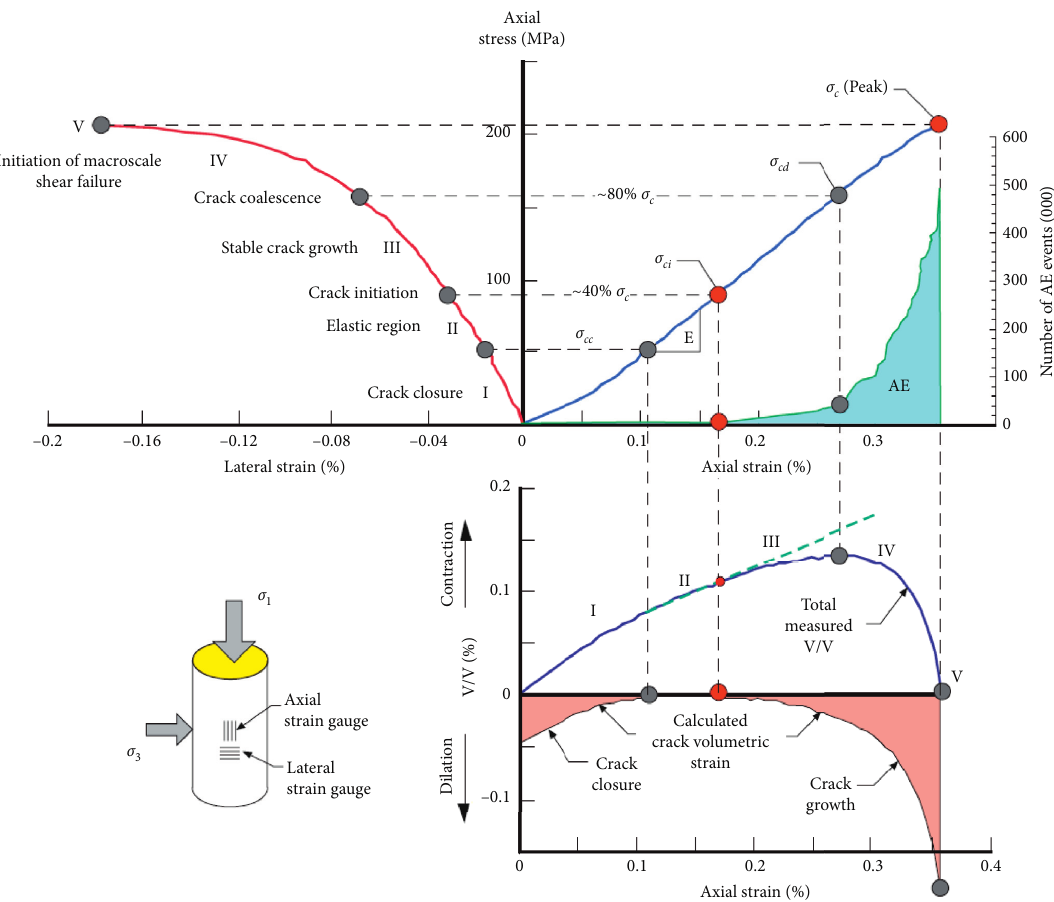
Figure 1: Stress-strain diagram of granite showing the stages of crack development (after